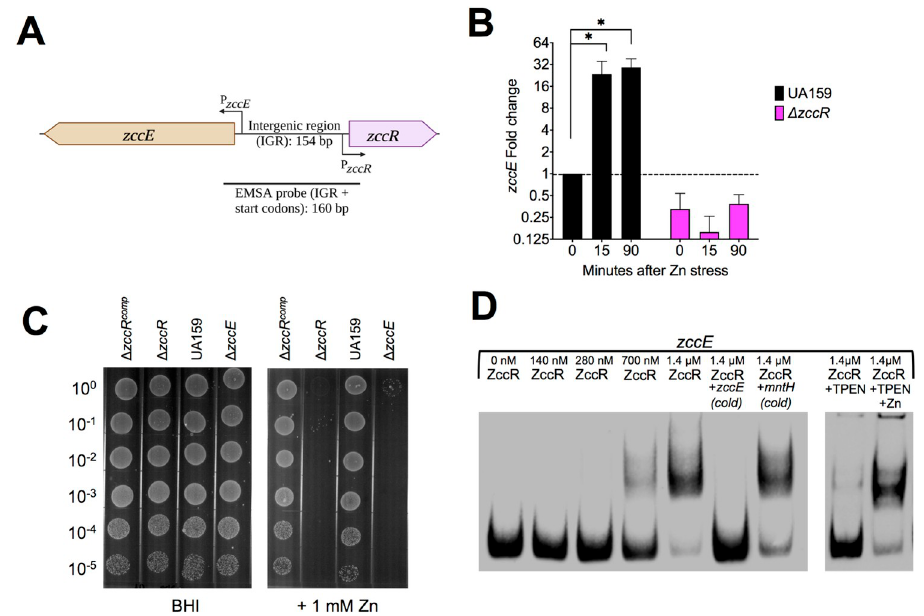
Fig 6. The MerR-type transcription factor ZccR is a positive regulator of zccE . (A) Genetic organization of zccE ( smu2057c ) and zccR ( smu2058 ) in the S . mutans UA159 chromosome (Created with BioRender.com). (B) qRT-PCR analysis of zccE mRNA expression in the Δ zccR strain relative to the parent UA159 strain before and after exposure to 4 mM Zn. Data represent means and standard deviations of results from 3 independent experiments. One-way ANOVA was used to determine significance ( � , p < 0.001; ns, not significant). (C) Plate titration (spot test) of UA159, Δ zccE , Δ zccR and Δ zccR comp strains on BHI with or without 1 mM Zn supplementation. Images were taken after 24 h incubation at 37˚C in 5% CO 2 and are representative of at least 3 independent experiments. (D) EMSA showing direct interaction of ZccR with the 160-bp zccE - zccR intergenic region (IGR). To determine ZccR binding specificity, addition of 100X (molar excess) of either non-biotin labeled (cold) zccE - zccR IGR or non-specific competitor DNA ( mntH promoter region) was added to the reaction. To explore the role of Zn on ZccR binding activity, 3 mM TPEN (Zn specific chelator) was added to the reaction alone or in the presence of 2.5 mM ZnSO 4